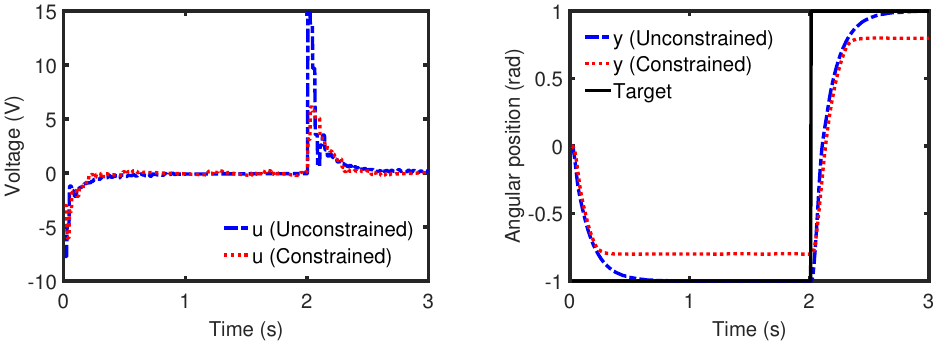
Figure 6. Unconstrained and constrained performance of PS-PFC for process G s